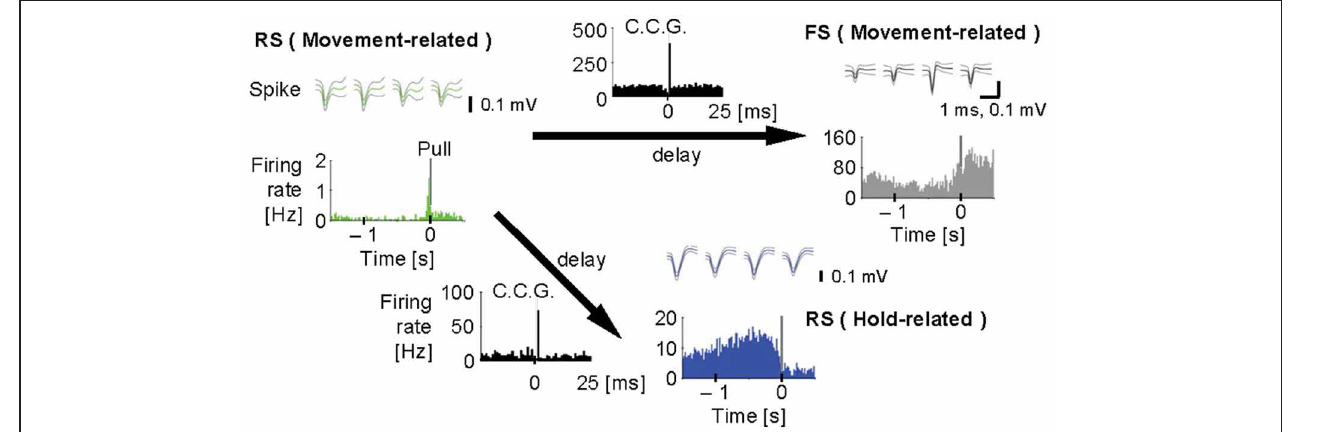
FIGURE 4 | Synchronous spiking among motor cortex neurons. Cross-correlograms (black, C.C.G.; 1ms bins) among a regular-spiking (RS) neuron with movement-related activity (green), an FS neuron with movement-related activity (gray), and another RS neuron with hold-related activity (blue). Top , spike waveforms [scale bars, 1ms (the same for all spike